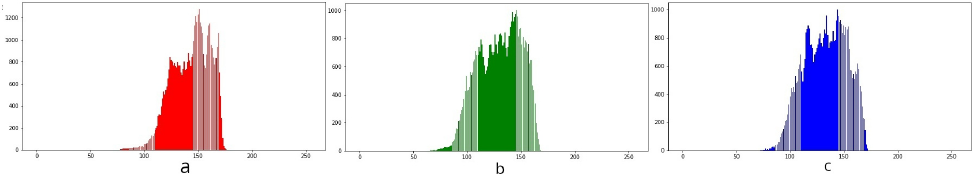
Figure 4. Color histograms of the test set for channels 0—red ( a ), 1—green ( b ), and 2—blue ( c